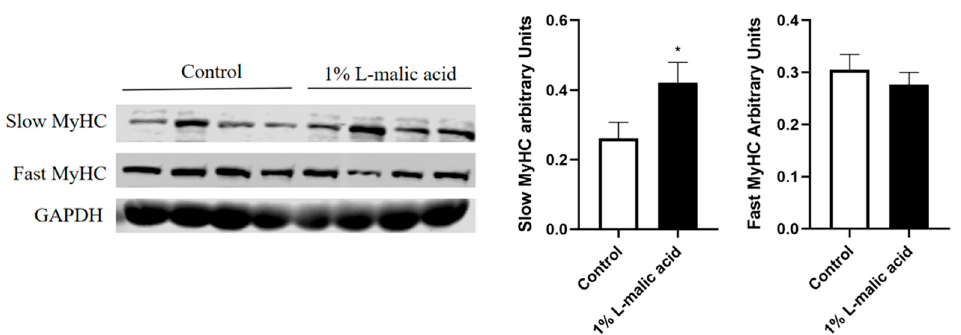
Figure 1. Effects of dietary supplementation with L-malic acid on muscle fiber type composition of the LD muscle ( n = 8). MyHC, myosin heavy chain. The statistical significance of difference between two means was calculated using t -test. * p < 0.05.